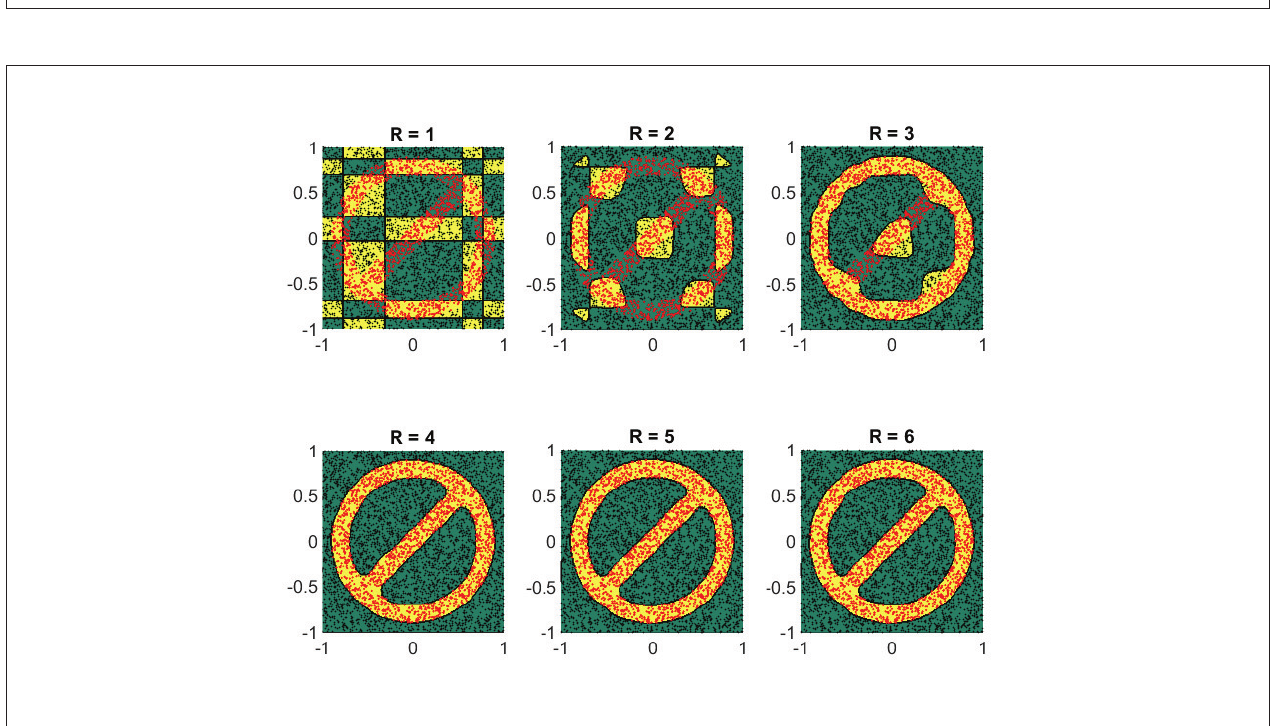
FIGURE 10 | For a classification set shaped in the form of a no-entry sign, at least four separable terms are required for a good classification. Shown are the obtained results on a synthetic dataset by using the logistic loss function (Equation 22). The recovered classification sets are marked by the yellow and green contours, whereas the labeled data used for training are marked by red and black